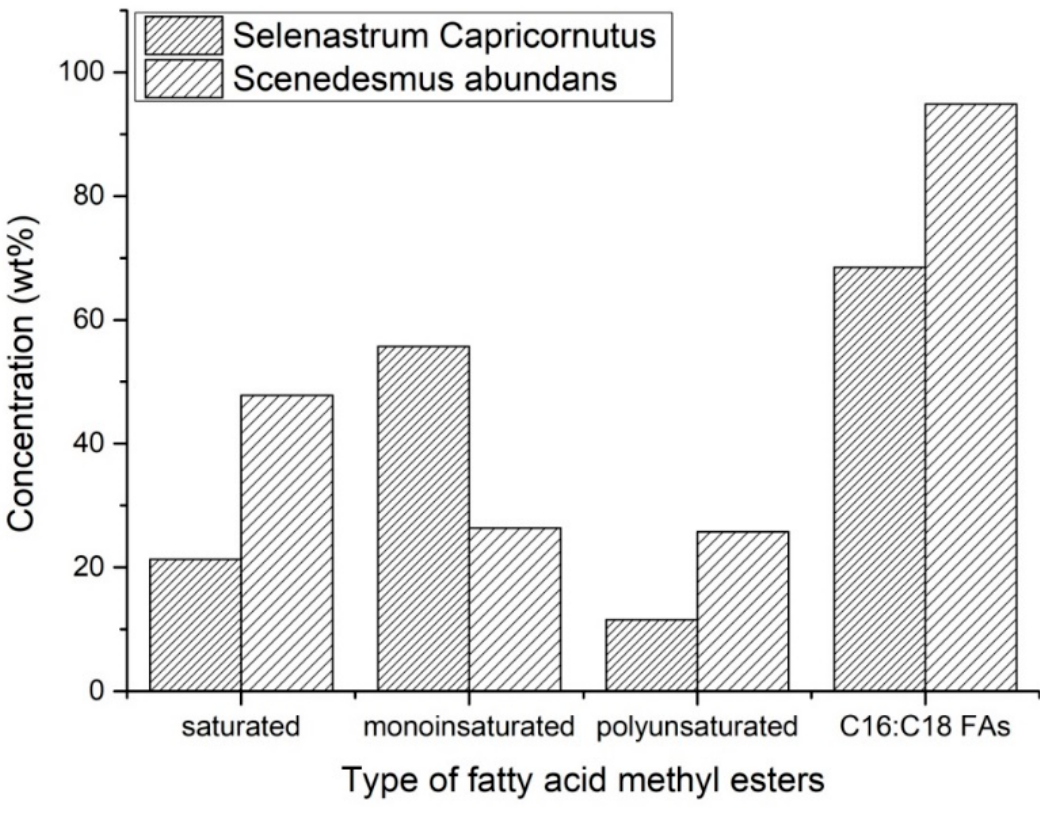
Figure 5. Comparison between Fatty Acid Methyl Esters of S. capricornutum obtained in the photobioreactor and Fatty Acid Methyl Esters produced from Scenedesmus abundans [24].